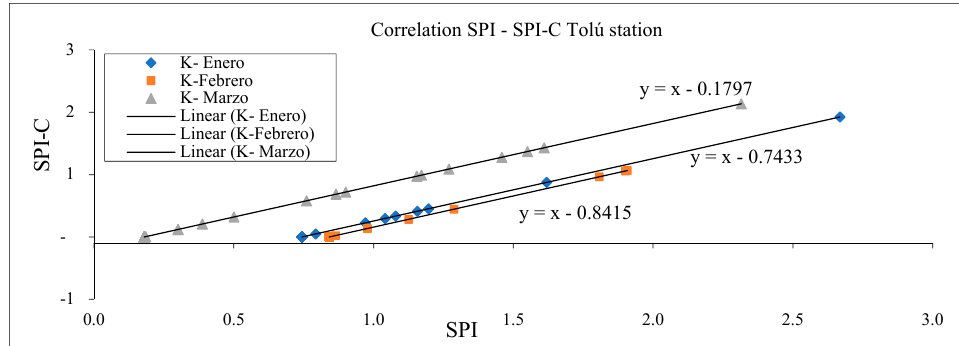
Figure 18. SPI-SPI-C, Tolú station correlation.